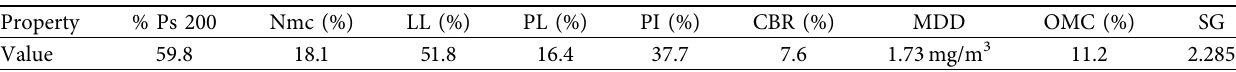
Table 3: Basic properties of the